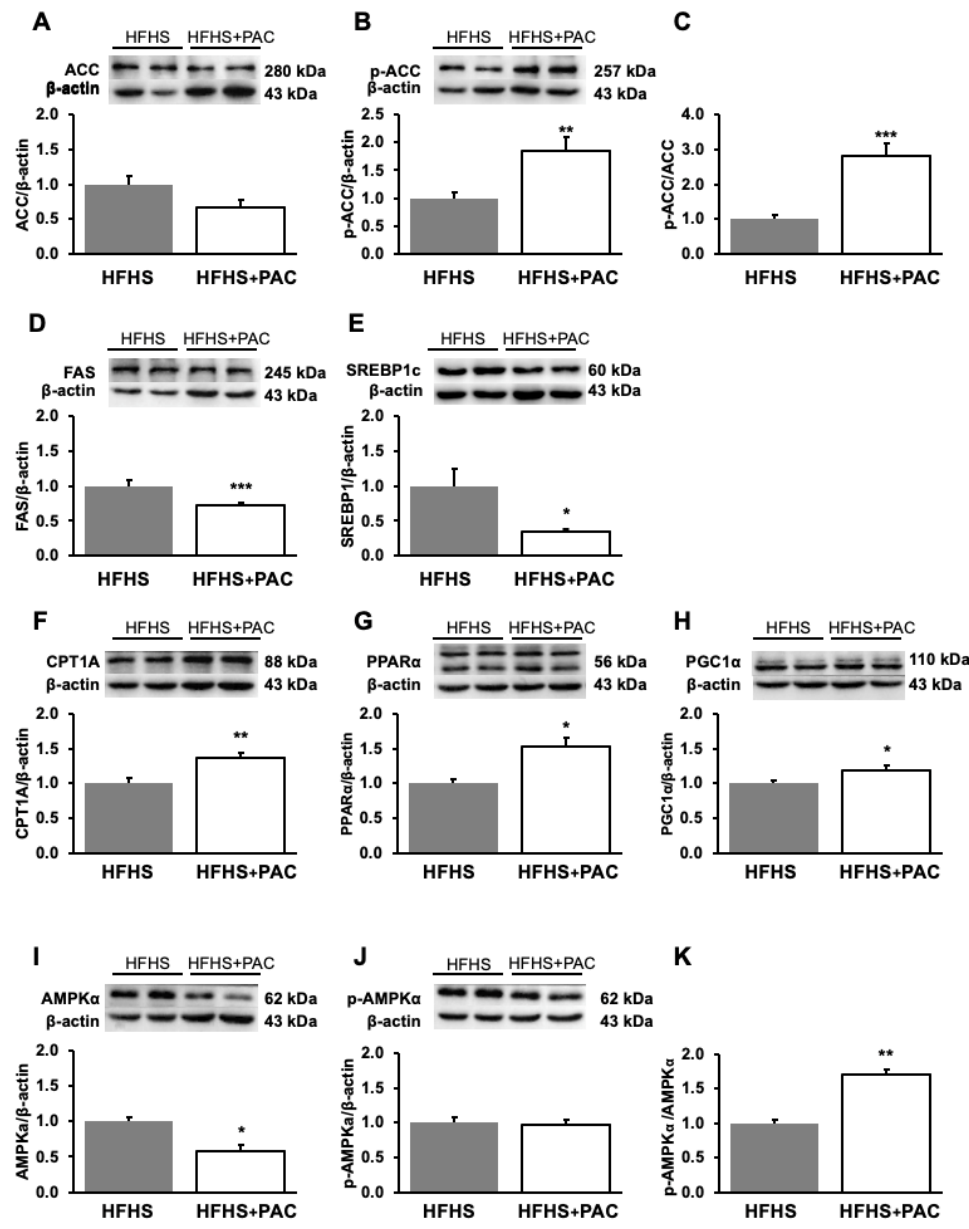
Figure 6. PAC modulates hepatic lipid metabolism. Protein expression of pivotal biomarkers influencing lipid metabolism and biogenesis was determined in liver by Western blot as described in Materials and Methods. ( A ) ACC, ( B ) p-ACC, ( D ) FAS, ( E ) SREBP1c, ( F ) CPT1A, ( G ) PPAR α , ( H ) PGC1 α , ( I ) AMPK α and ( J ) p-AMPK α protein mass was determined. ( A ) ACC and ( B ) p-ACC as well as ( I ) AMPK α and ( J ) p-AMPK α were blotted on separate gels and normalized using their respective β -actins; the ( C ) p-ACC/ACC and ( K ) p-AMPK α /AMPK α ratios were then calculated. Data are expressed as the mean ± SEM for n = 4–8 mice/group with a representative gel per experiment. * p < 0.05, ** p < 0.01, *** p < 0.001 vs. HFHS mice. Each set of experiments, including the proteins of interest and their β -actin (as a reference protein and a loading housekeeping control) was run on the same gel. ACC: acetyl-CoA carboxylase; p-ACC: Phosphorylated-acetyl-CoA car- boxylase; FAS: Fatty acid synthase; SREBP1c: Sterol regulatory element binding protein-1c; CPT1A: Carnitine palmitoyl transferase 1 isoform A; PPARα: Peroxisome proliferator activated receptor al- pha; PGC1α: Peroxisome proliferator activated receptor gamma coactivator 1 alpha; AMPKα: AMP- activated protein kinaseα; p- AMPKα: Phosphorylated-AMP-activ ated protein kinaseα.